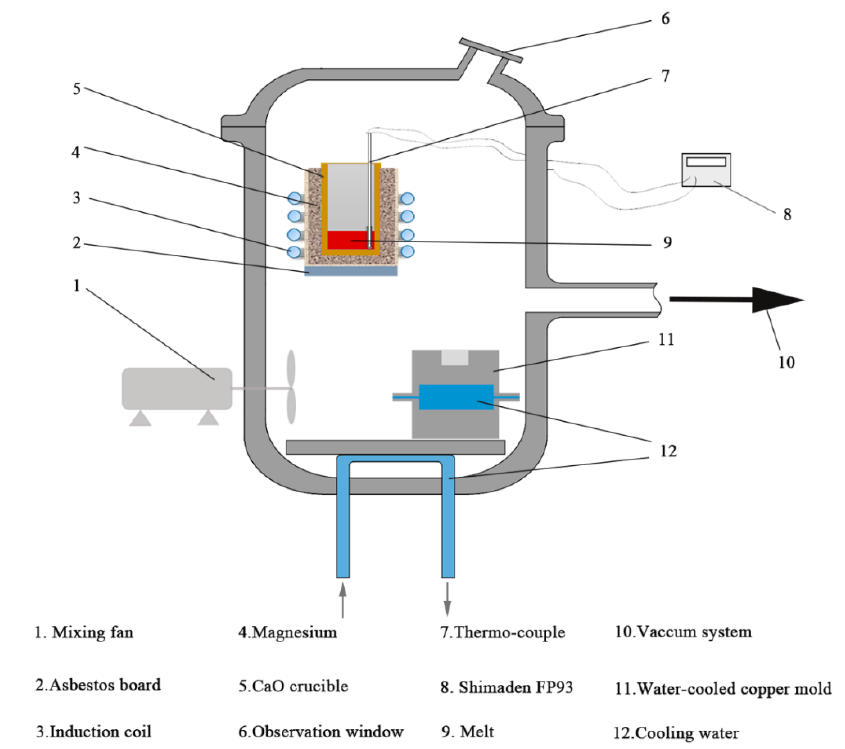
Figure 1. Schematic diagram of the experimental apparatus. Table 1. Purity of raw